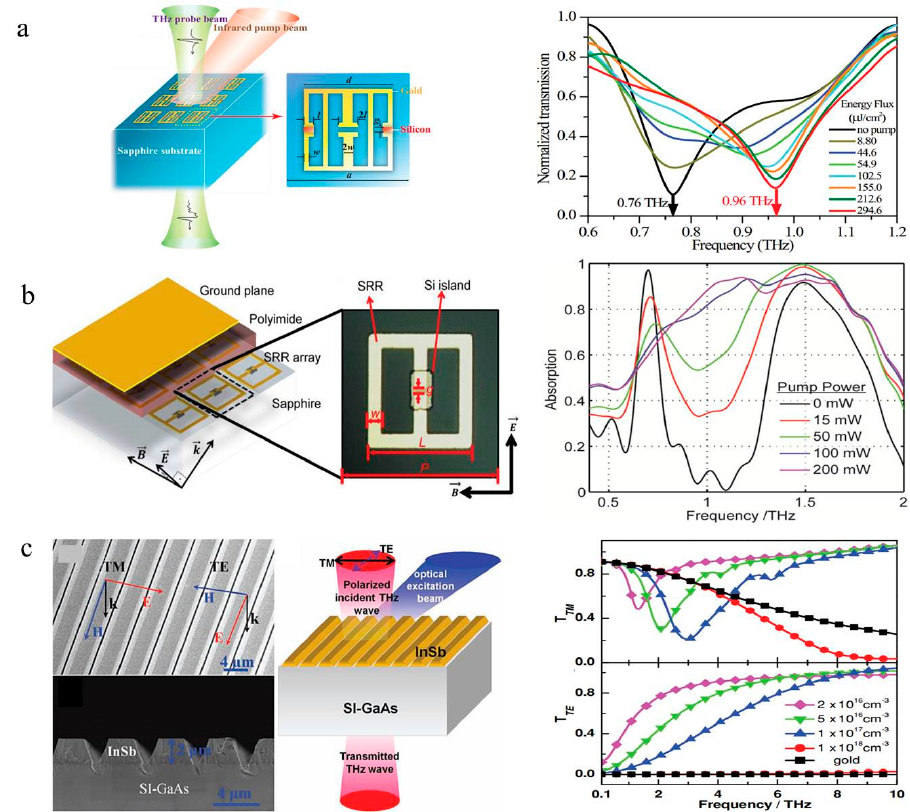
Figure 5. ( a ) Schematic of the metamaterial embedded with silicon in the gap. The resonant frequency shifts from 0.76 to 0.96 THz by changing the luminous flux. Reproduced with permission from [42], copyright American Physical Society, 2011. ( b ) Diagram of the absorber composition and results. The absorption intensity is tuned by applying different pump light intensity. Reproduced with permission from [43], copyright John Wiley and Sons, 2014. ( c ) Micrograph of the grating structure. with different electron concentrations, the transmission of TE and TM wave responses differently. Reproduced with permission from [44], copyright John Wiley and Sons, 2013.